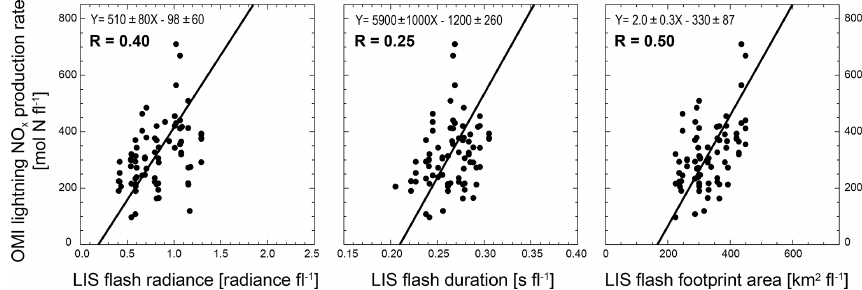
Figure 7. Relationship between OMI and GEOS-Chem derived lightning NO x production rates and LIS lightning properties: energy (radi- ance), duration, and footprint area. Individual points are seasonal mean 20 ◦ × 32 ◦ grid squares at 40 ◦ N–40 ◦ S.